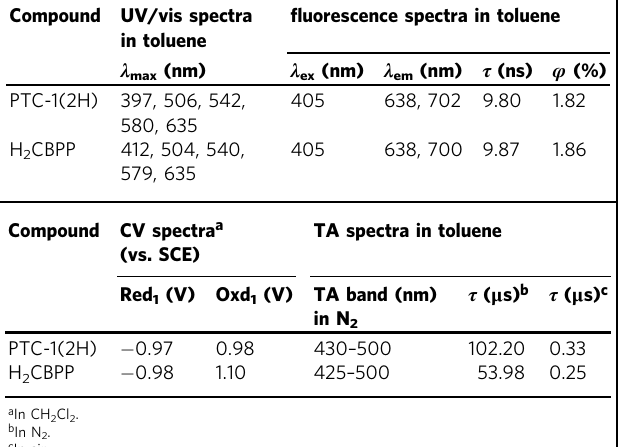
Table 1 Photophysical and electrochemical data for H 2 CBPP and PTC-1(2H).